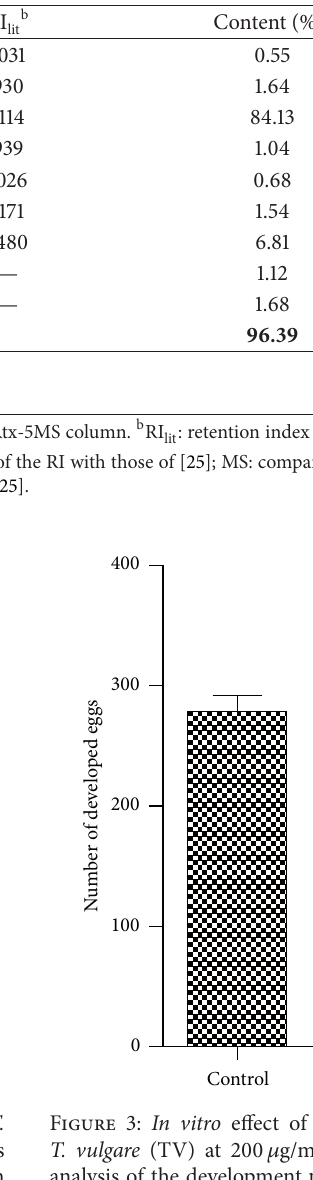
Table 2: Composition of the essential oil of T. vulgare (TV-EO) identified by CG/MS analysis.